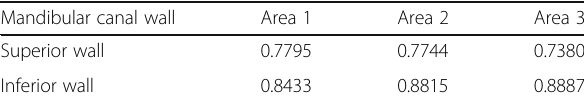
Table 1 κ -values for interobserver